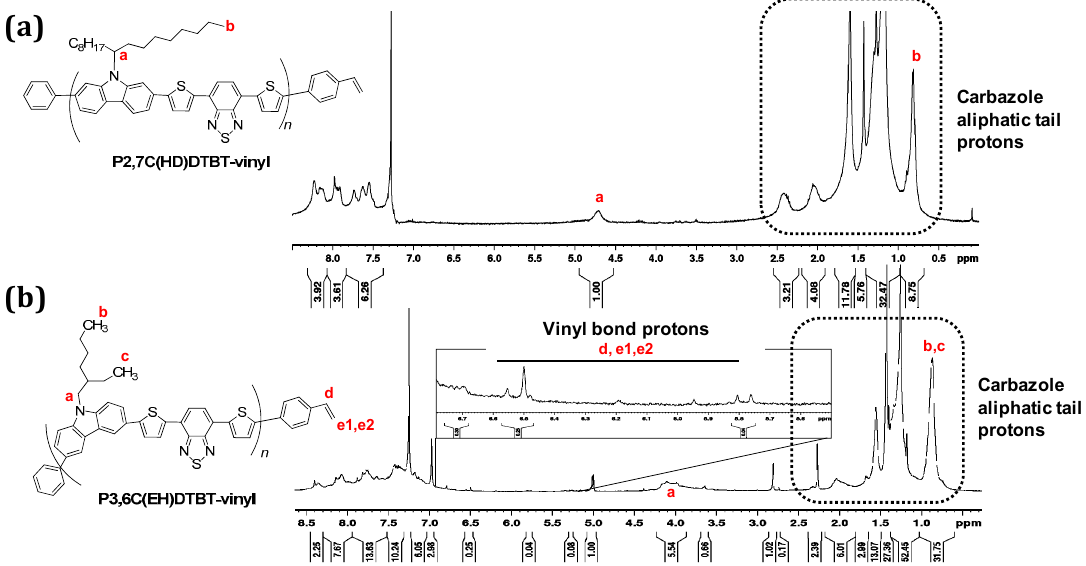
Figure 1. ( a ) 1 H NMR spectrum of P2,7C(HD)DTBT-vinyl in CDCl 3 and ( b ) 1 H NMR spectrum of P3,6C(EH)DTBT-vinyl in CDCl 3.